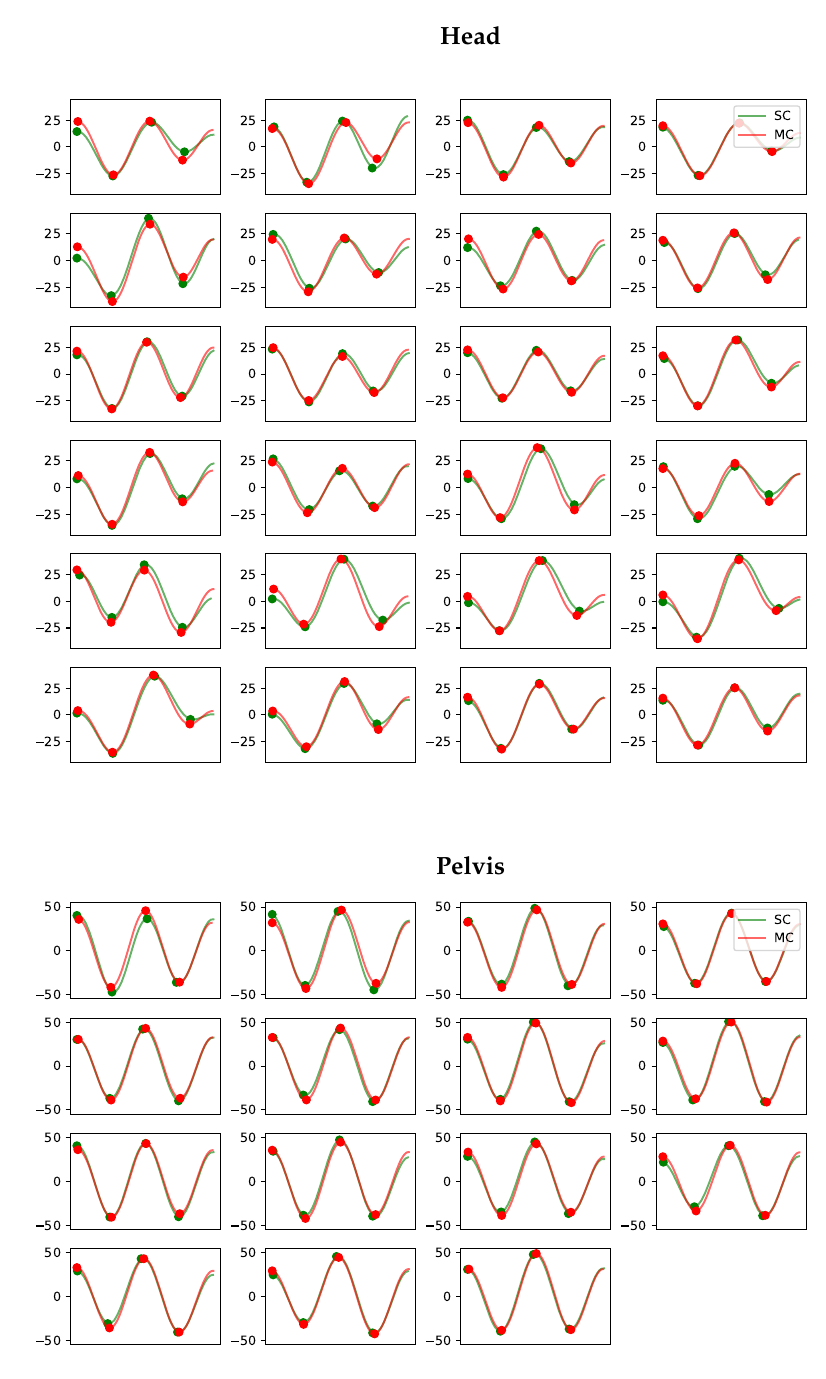
Figure A17. Vertical displacement signals per stride for the head and pelvis for horse 18. Each subplot contains the matched stride segments for the single-camera markerless system (SC) in green and the multi-camera marker-based system (MC) in red. The y-axis shows the vertical displacement in millimeters. The four dots on each curve indicate the positions of the two peaks and two valleys extracted using the approach in Section